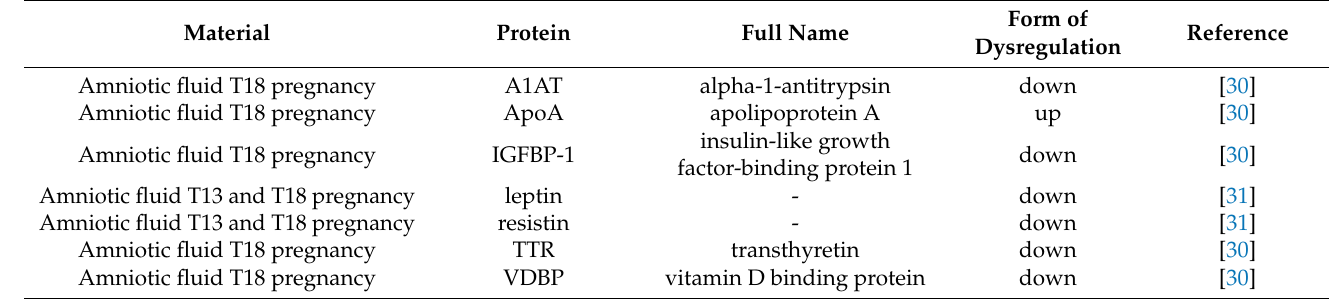
Table 1. Disturbances in protein concentrations related to T13 and T18 pathogeneses